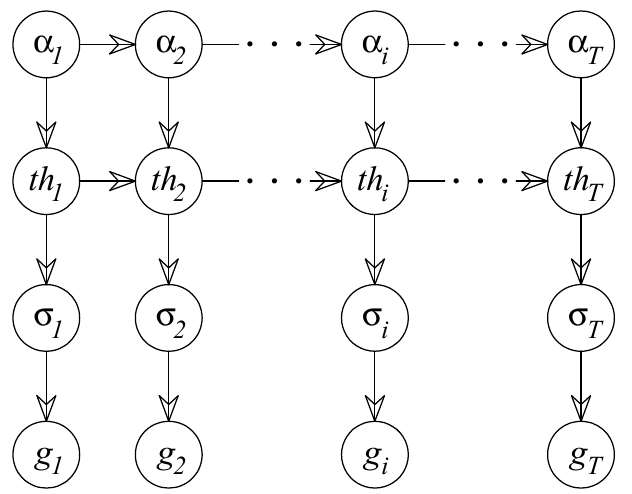
Figure 6. DBN modeling of the marine growth process and limit state assessment.